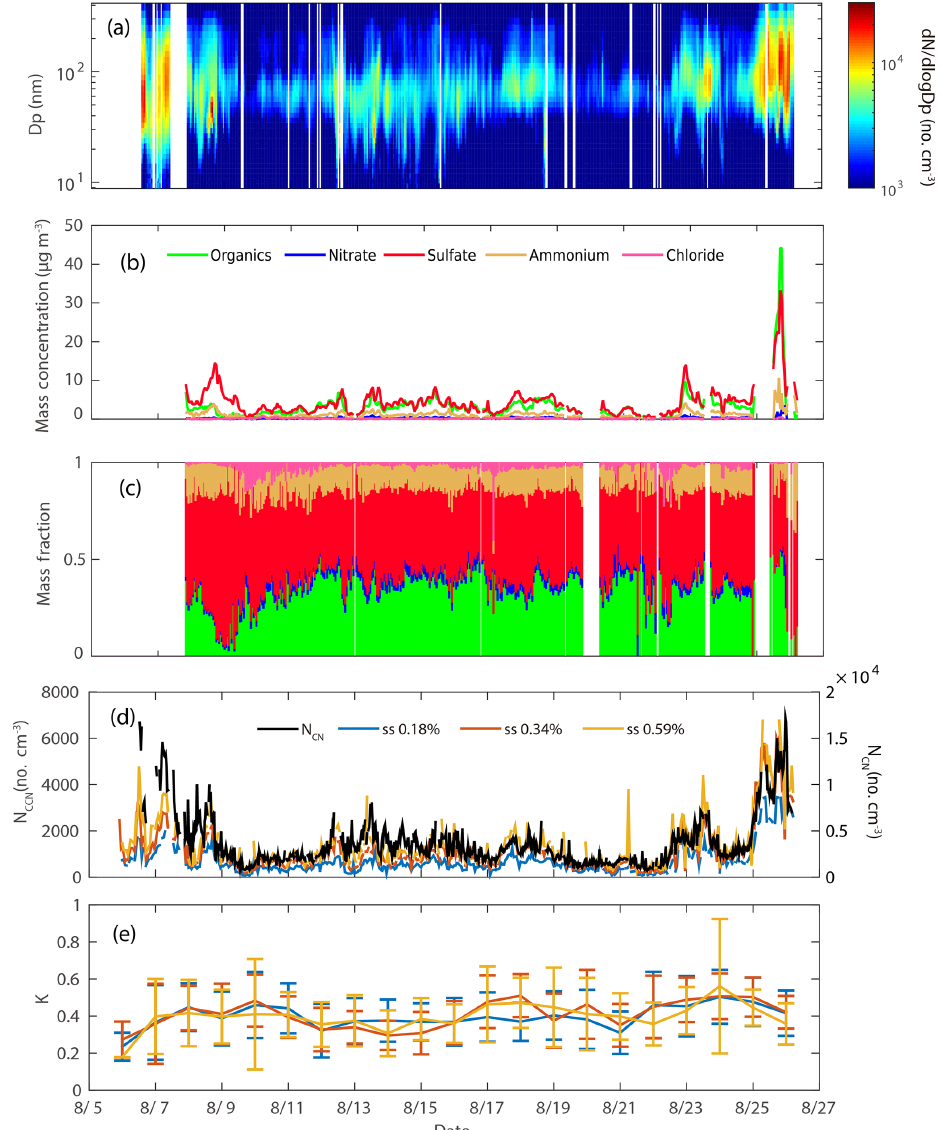
Figure 2. Temporal profiles of the measured particle number size distribution (a) , mass concentration (b) and mass fraction (c) of chemical composition, N CCN , and N CN (d) and the daily averaged κ values with the upper and lower error bars (e) . No data are shown between 6 and 8 August due to the instrumental failure of the